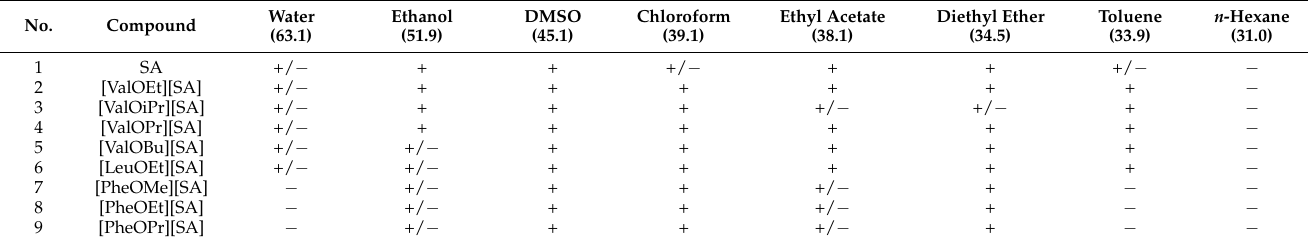
Table 3. Solubility in typical solvents of salicylic acid and amino acids alkyl esters salicylates at 25 ◦ C.